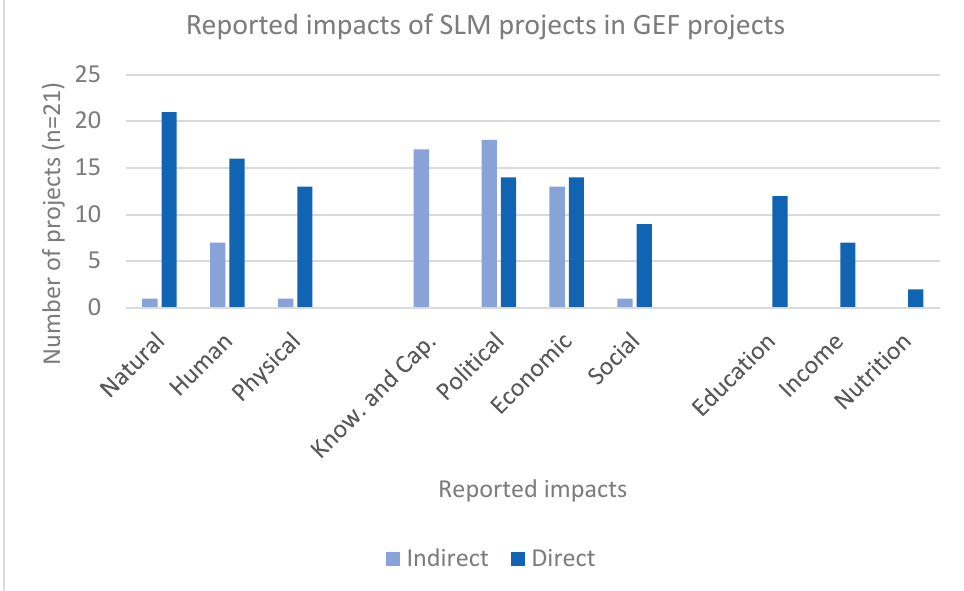
Figure 4. Impacts of GEF SLM projects in the four target countries in the Sahel region, as reported in project evaluations.